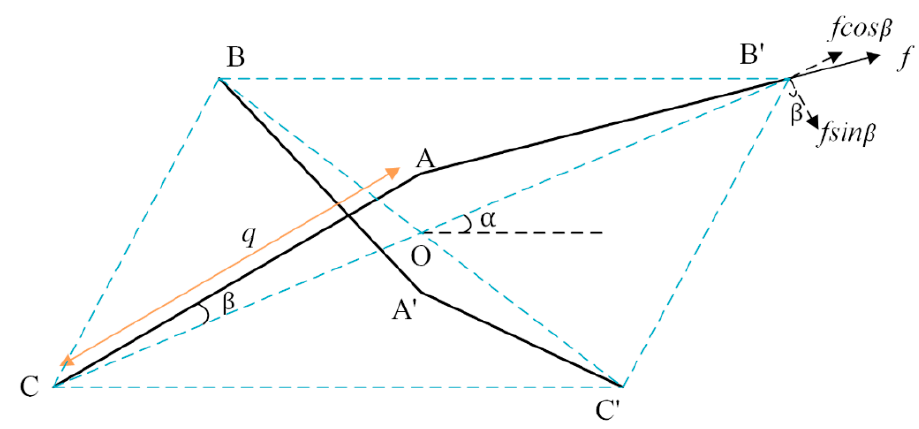
Figure 5. Diagram of the unit cell.